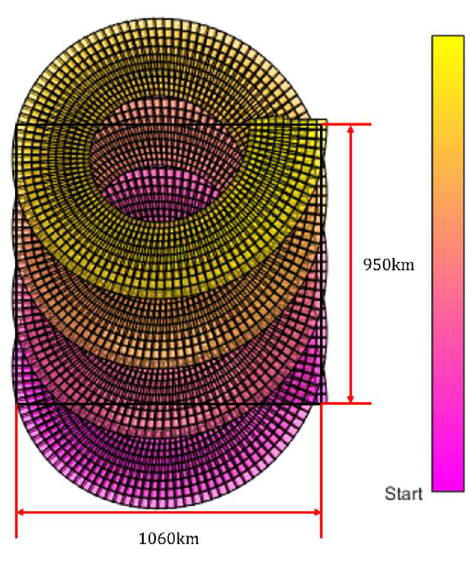
Figure 20. Single-camera constant Speed OCPSI mode ground cover simulation.